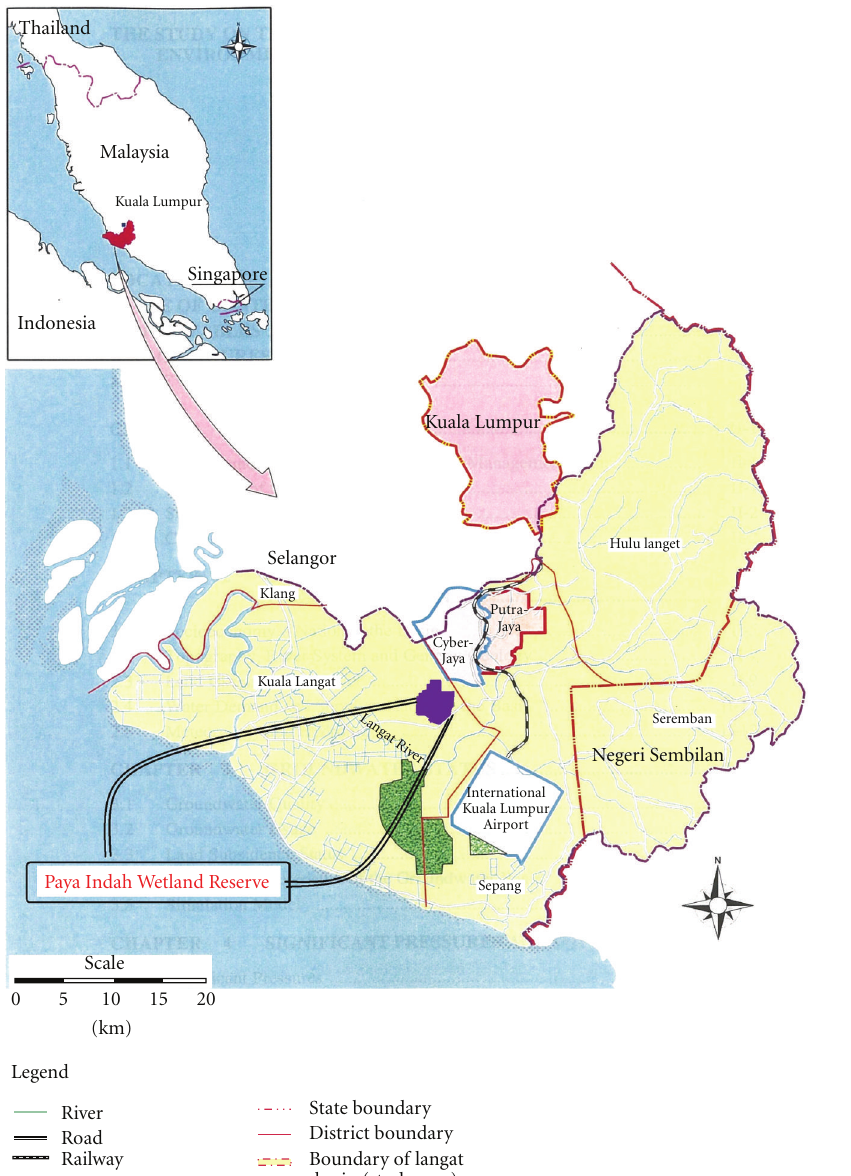
Figure 1: Location map of the Paya Indah Wetland Reserve, Peninsular